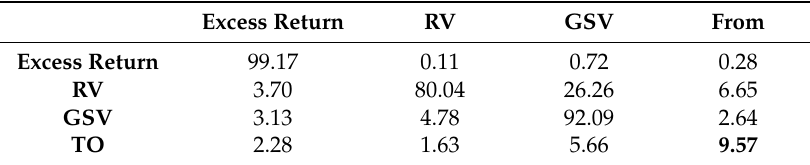
Table 12. Total spillover, Bulgaria.